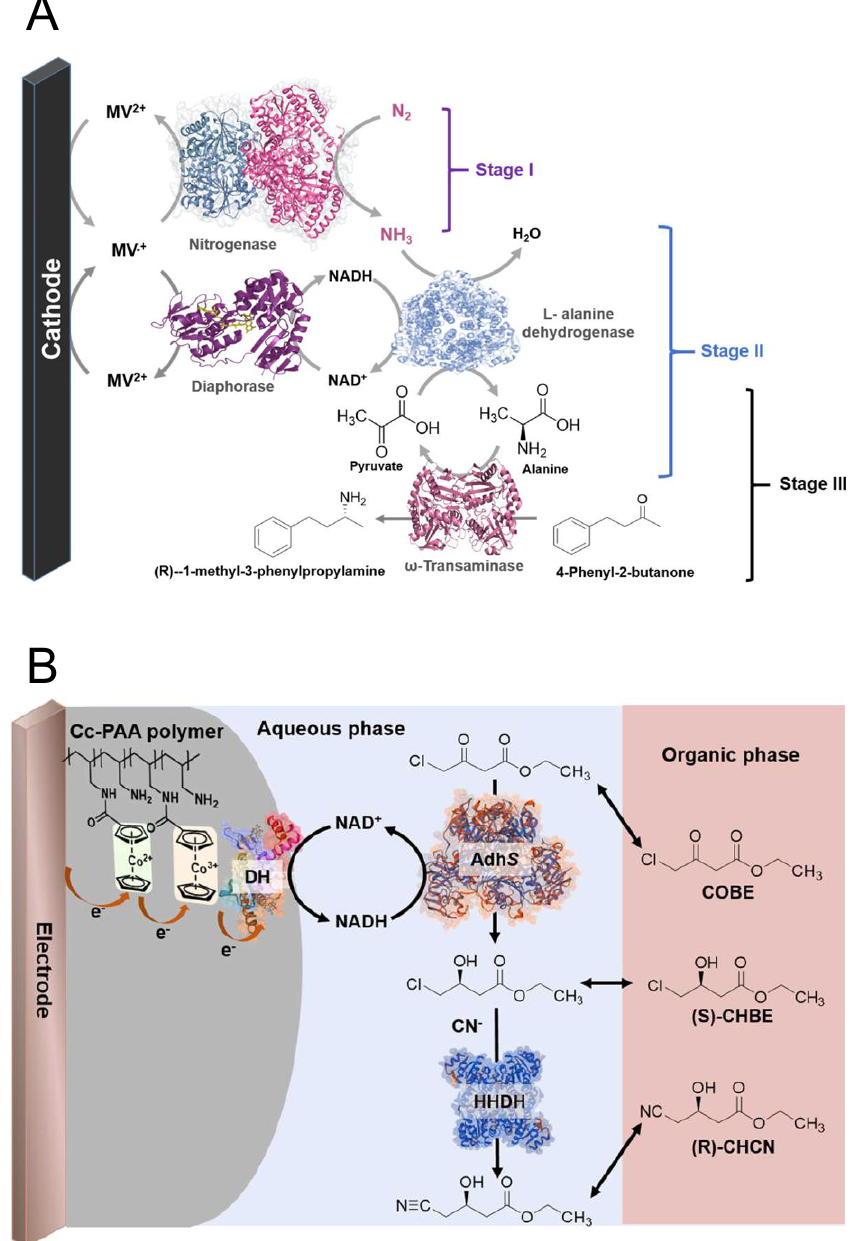
Figure 5. Schematic representation of multienzymatic bioelectrosyntheses of ( A ) chiral amine and ( B ) β -hydroxy nitrile. Abbreviations; DH: diaphorase, AdhS: alcohol dehydrogenase, HHDH: halohydrin dehalogenase, COBE: 4-chloroacetoacetate, CHBE: 4-chloro-3-hydroxybutanoate, CHCN: ethyl-4-cyano-3-hydroxybutyrate. Reprinted from Ref. [152,153], Copyright (2019,2020), with permission from ACS Publications.